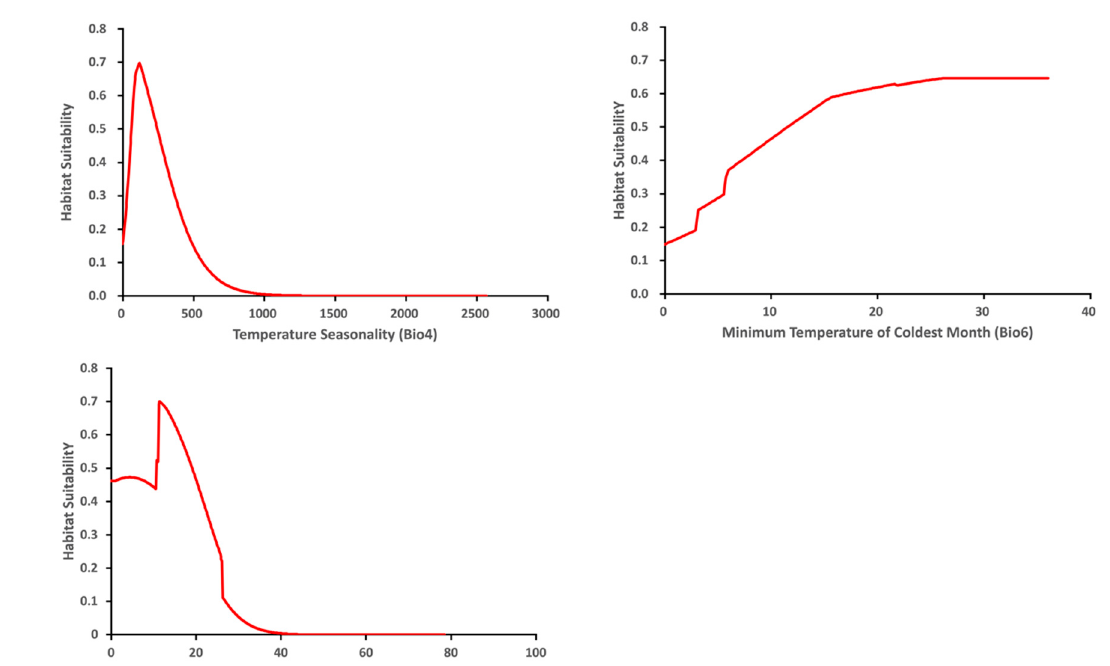
Figure 6. Relationship of habitat suitability response for Thaumatotibia leucotreta to three environmental variables (Bio4, Bio6, Bio7) (Units: Temperature °C).